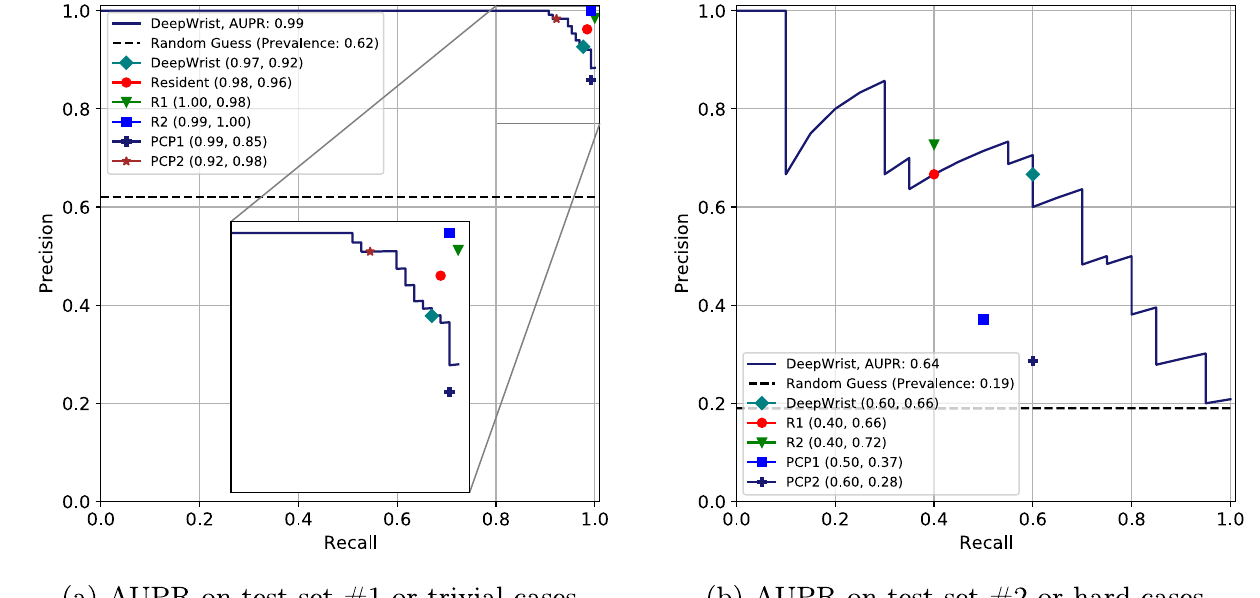
Figure 3. ( a ) AUPR performance on the test set #1 for DeepWrist, radiology resident, two radiologists (R1 & R2), and two primary care physicians (PCP1 & PCP2), ( b ) AUPR performance of DeepWrist and other graders on the test set #2. The plot highlights the drop in performance for both—human raters of different expertise, and our method.